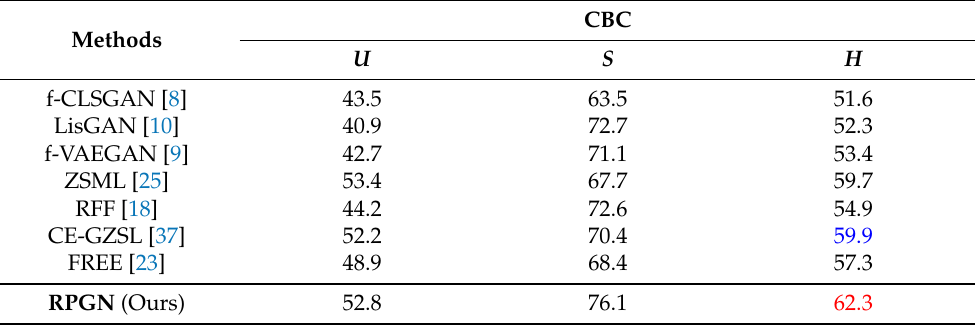
Table 4. Comparative results with other methods on CBC. Red font and blue font denote the highest and the second highest results,